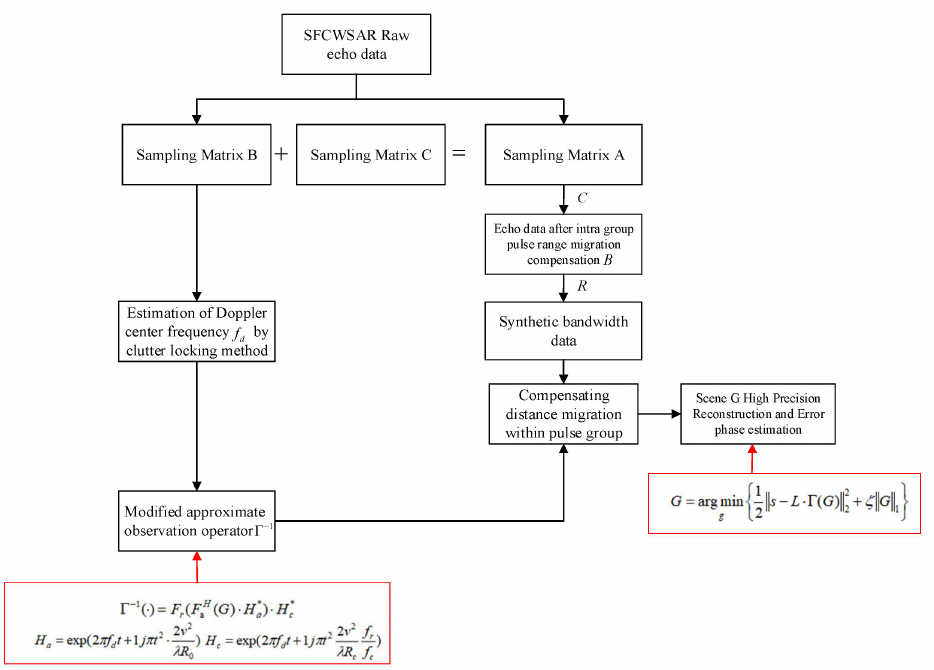
Figure 5. Flow chart of the sparse reconstruction algorithm based on the approximate observation operator SFCWSAR to compensate for the range migration within the pulse group and correct the Doppler Center Frequency.